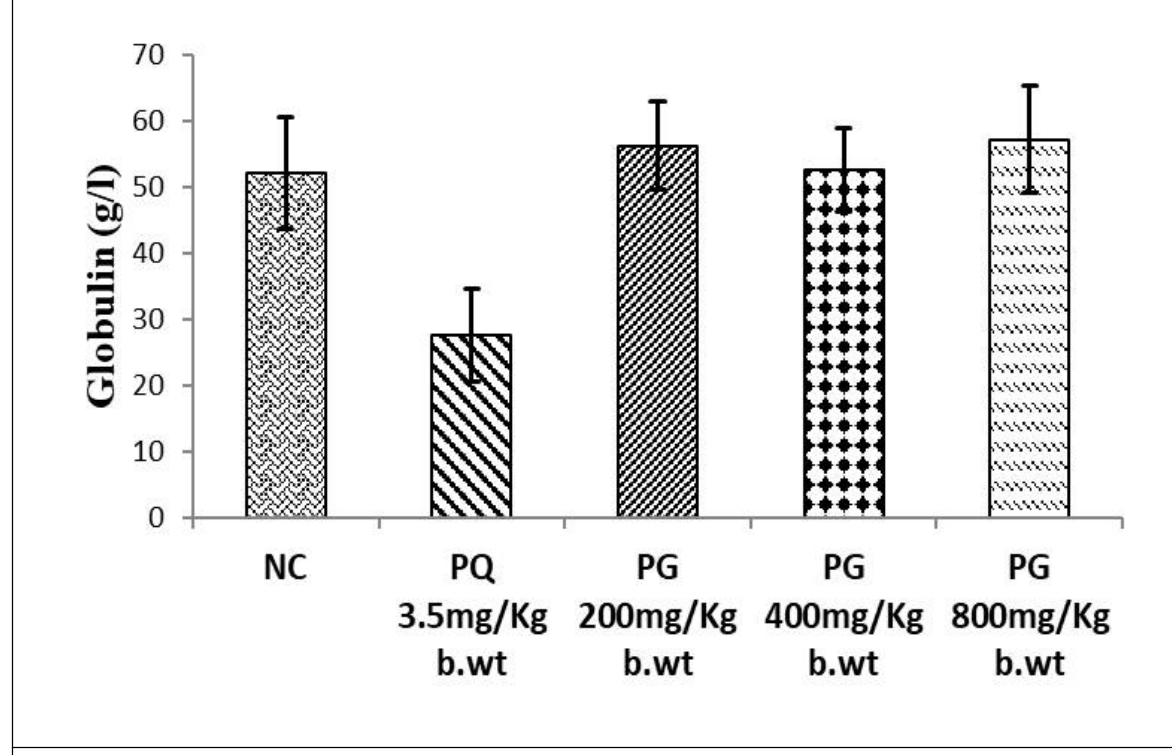
Figure 4: Effect of Psidium guajava leaf extract administration on serum globulin concentration of male Wistar albino rats administered 3.5 mg/kg b.wt. Paraquat